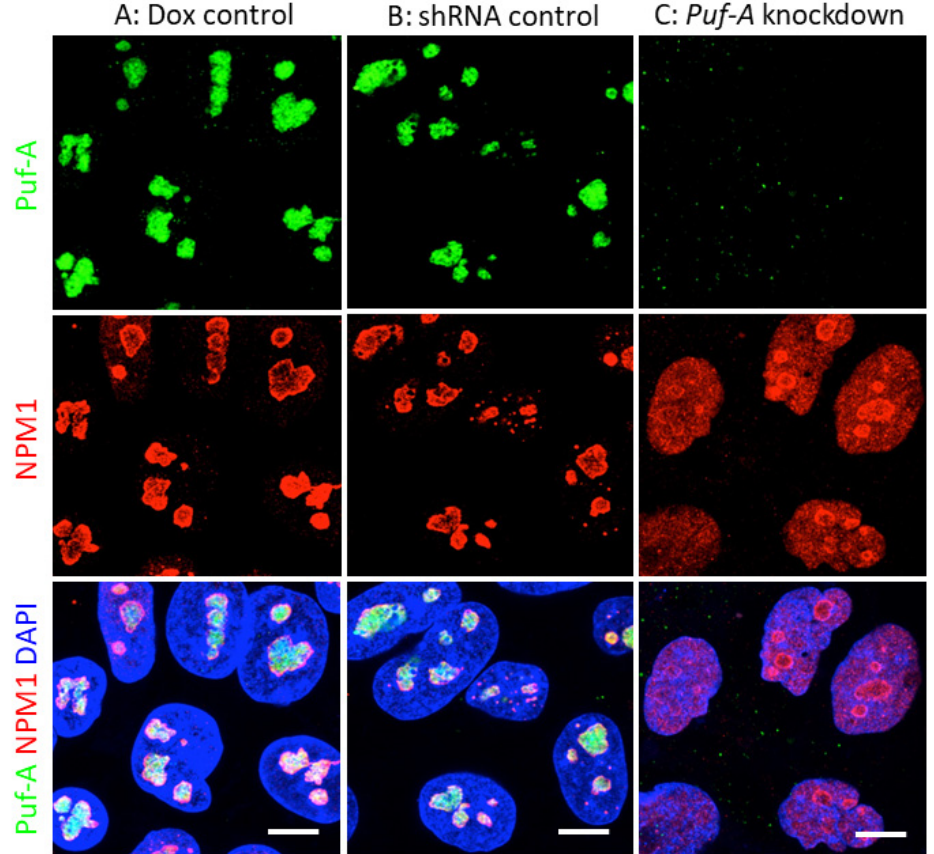
Figure 4. Puf-A is localized in the nucleolus of PGCs. PGCs were immunostained with anti-Puf-A antibody (green), then co-stained with anti-NPM1 antibody (red) and DAPI (blue). ( A , B ) PGCs from the Dox control ( A ) and shRNA control ( B ) embryos showed that Puf-A and NPM1 were co-localized and formed multiple clusters within the nucleus. ( C ) PGCs from embryos of Puf-A knockdown mice had no Puf-A expression and NPM1 was dispersed throughout the nucleoplasm. Scale bars, 10 µ